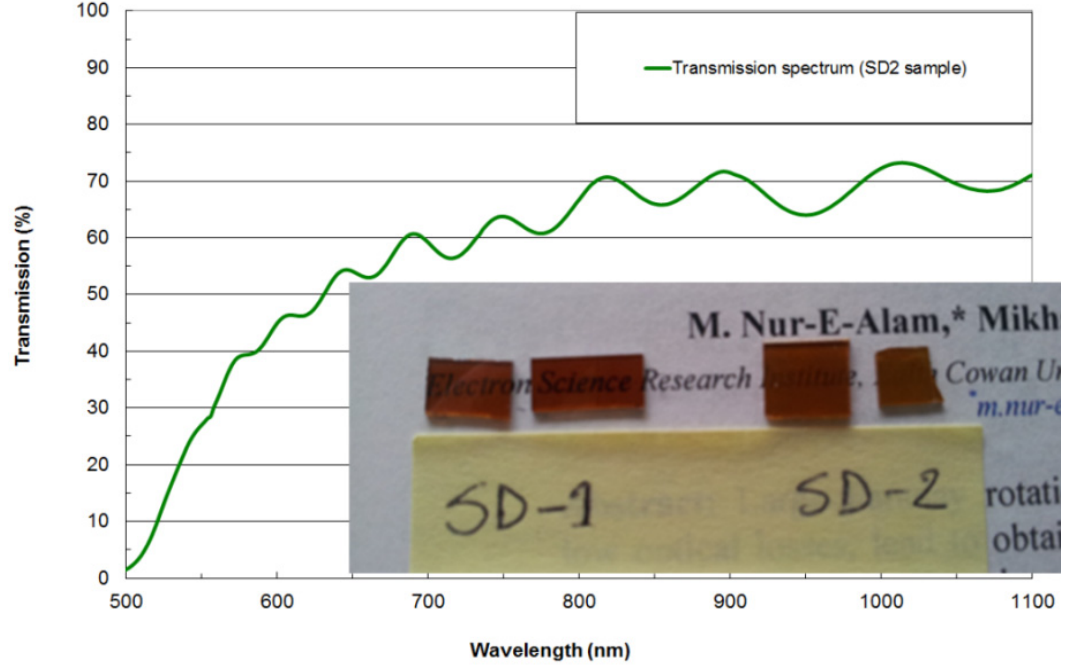
Figure 3. Measured transmission spectrum of a multilayer garnet structure (SD2) defined as (Sub (GGG)/(500 nm Bi 2 Dy 1 Fe 4 Ga 1 O 12 : 17 vol. % Bi 2 O 3 )/500 nm Bi 1.8 Lu 1.2 Fe 3.6 Al 1.4 O 12 / (500 nm Bi 2 Dy 1 Fe 4 Ga 1 O 12 : 17 vol. % Bi 2 O 3 )) prepared on a GGG (111) substrate